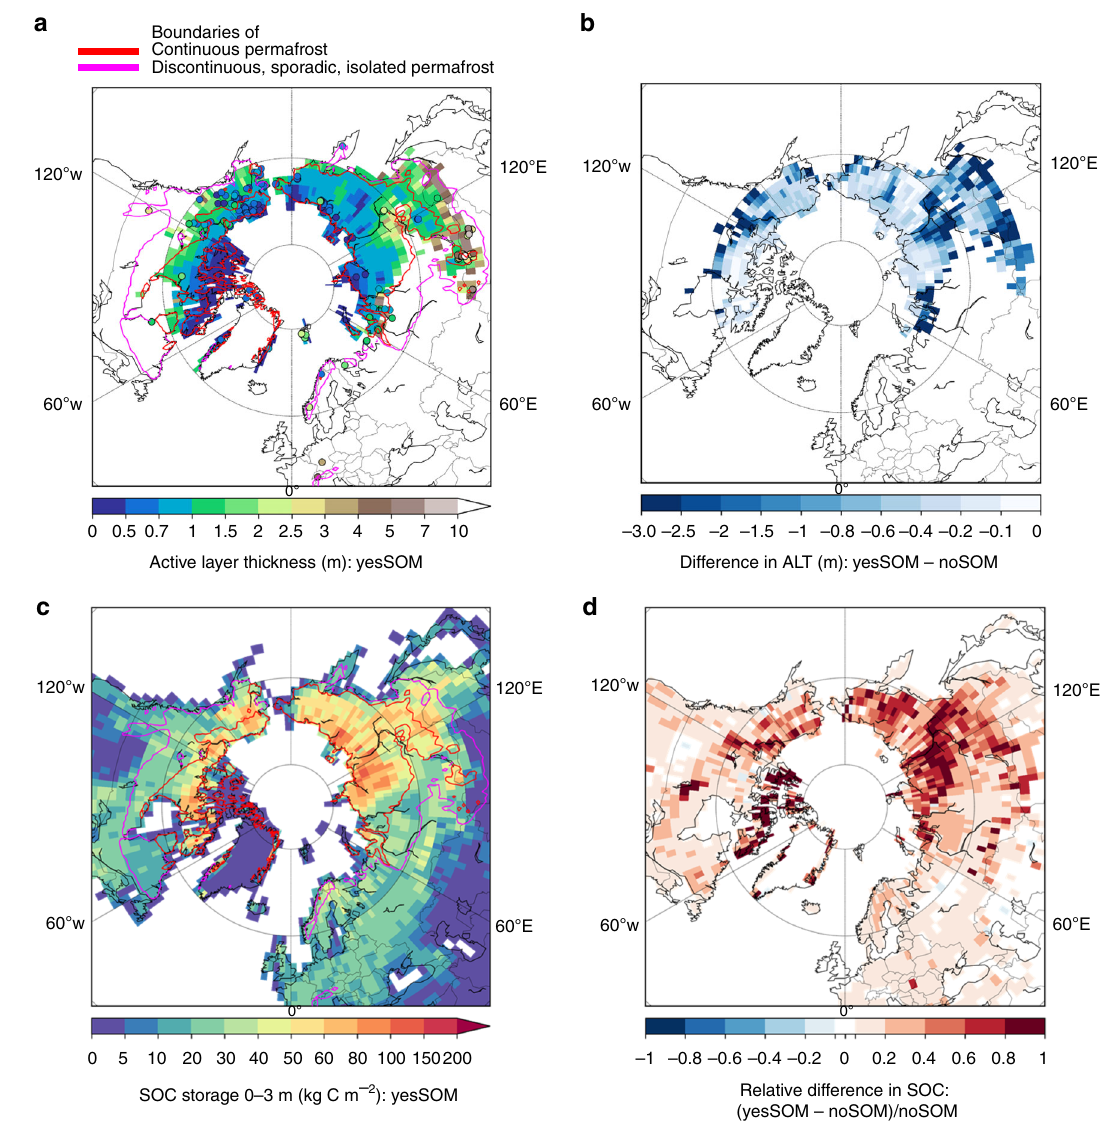
Fig. 3 Impact of organic matter on modelled active layer thickness (ALT) and soil organic carbon (SOC). a , b Modelled mean ALT during 1990 – 2010 from yesSOM ( a ) and the difference between yesSOM and noSOM ( b ). The color- fi lled circles on ( a ) indicate observations from the CALM network. c , d Modelled mean SOC during 1990 – 2010 from yesSOM ( c ), and its relative difference against noSOM ( d ). The red and magenta lines indicate boundaries of northern permafrost according to the IPA map